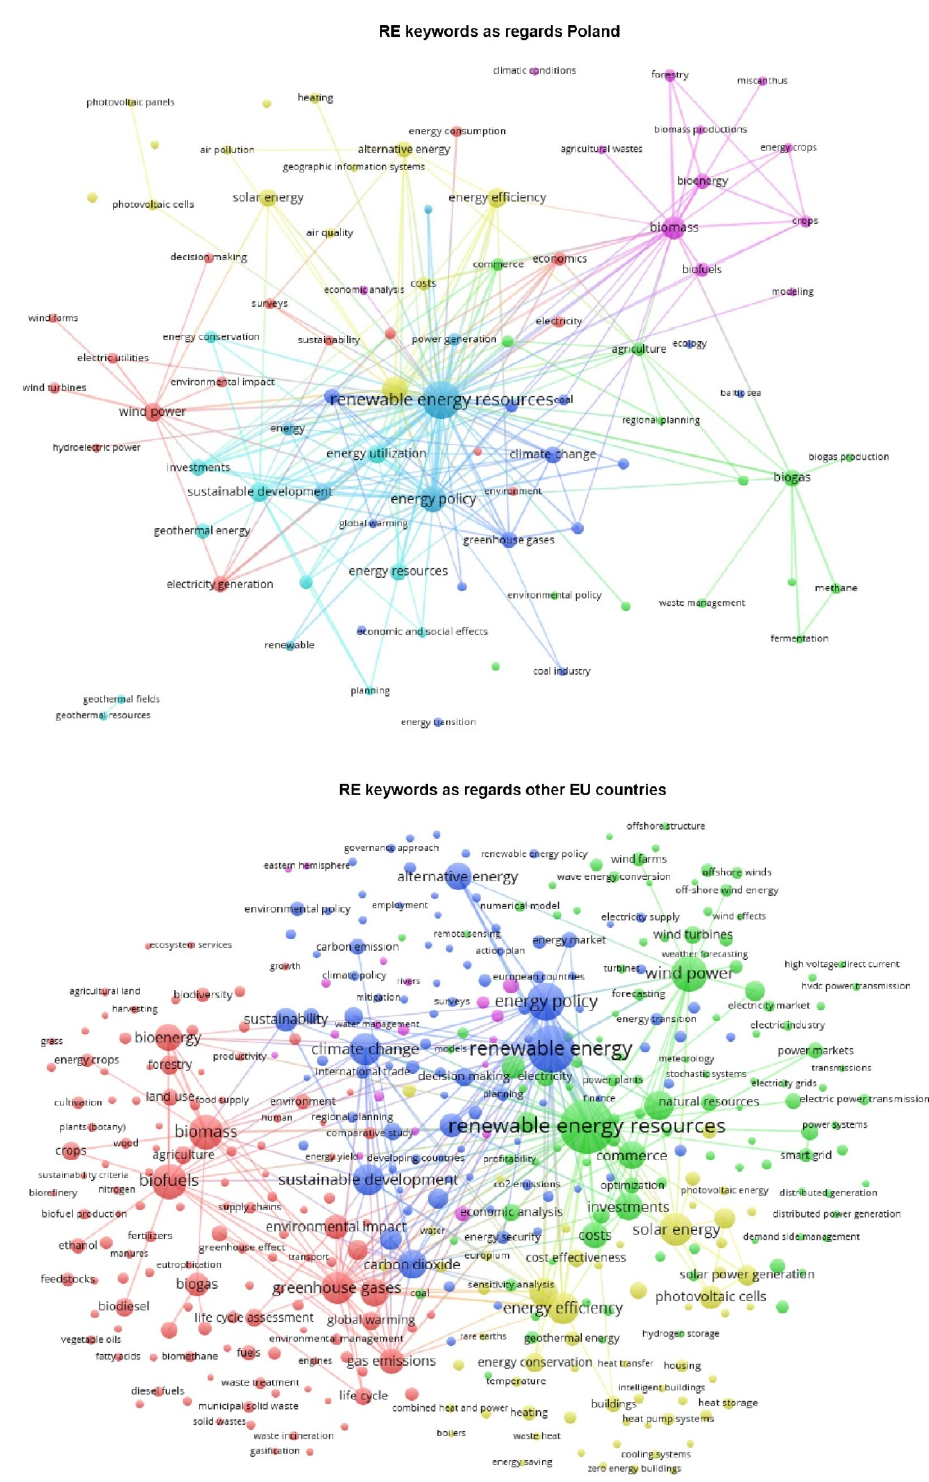
Figure 3. Keywords and keywords co-occurrence mapping for publications on RE research.